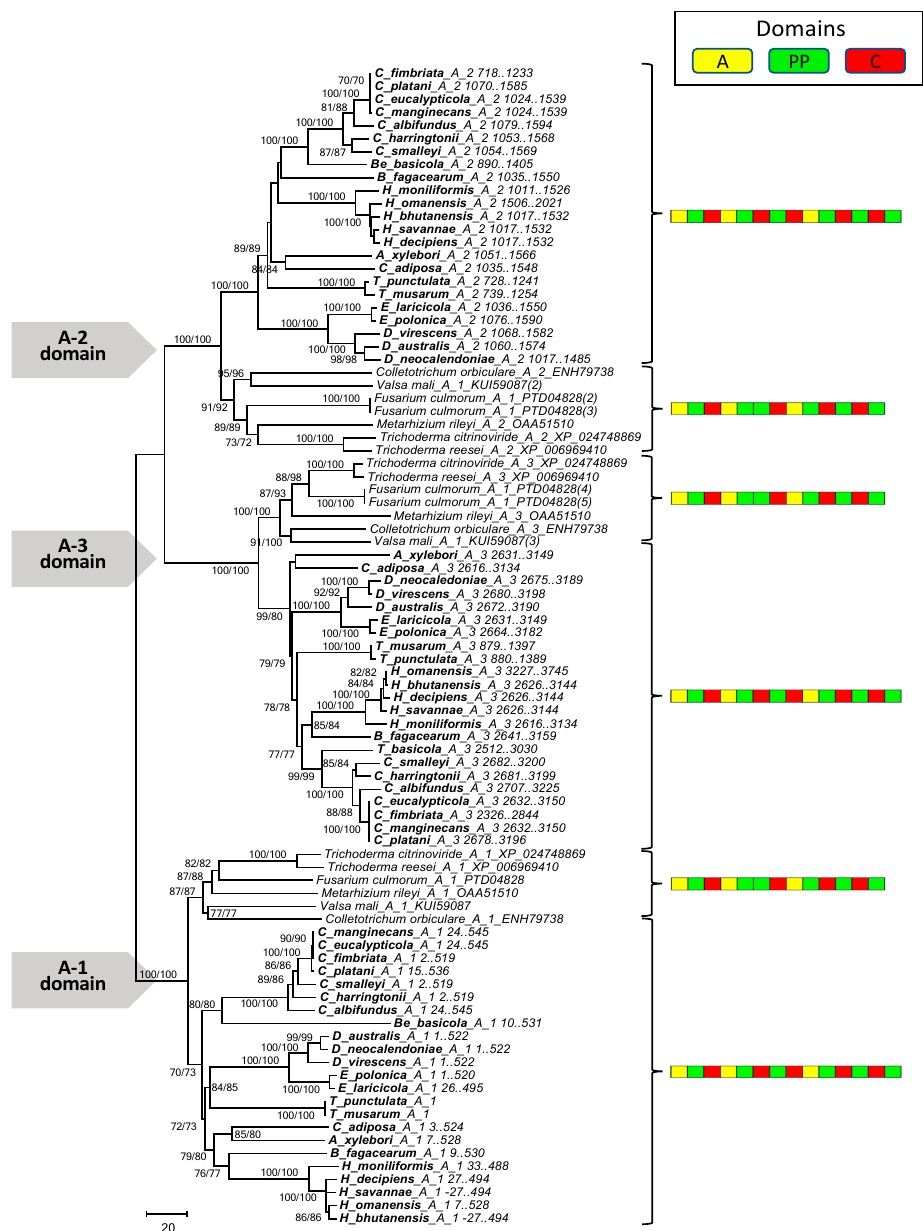
Figure 5. Phylogenetic relationships of taxa based on the inferred protein sequences of A domains of the multimodular NRPS genes examined. The panel to the right indicates the domain structure of the NRPS genes in the respective clusters. The tree was generated with the neighbor-joining (NJ) method in MEGA v.7 using the JTT + I + G model. Similar groupings were obtained using maximum likelihood (ML) analysis and the same model parameters. Branch support is indicated at the internodes ( > 50% bootstrap values based on a 1000 repeats) in the order NJ/ML.